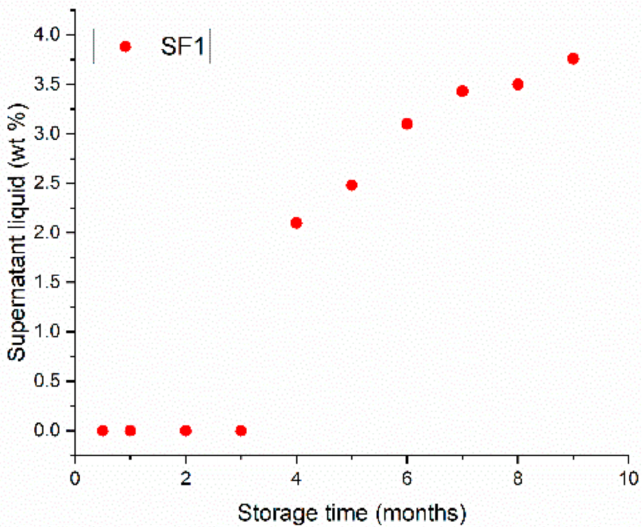
Figure 1. Weight percentage of supernatant as a function of storage time of a CBR gel with 1 wt.% surfactant (gel